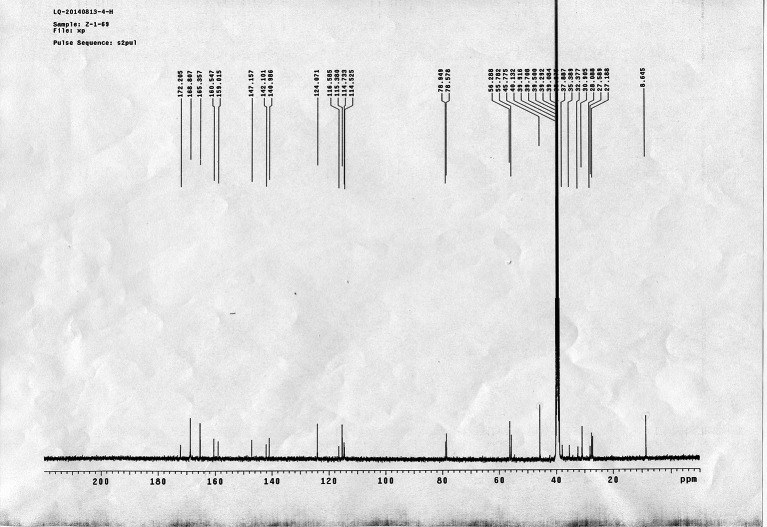
13C NMR spectra of AL.